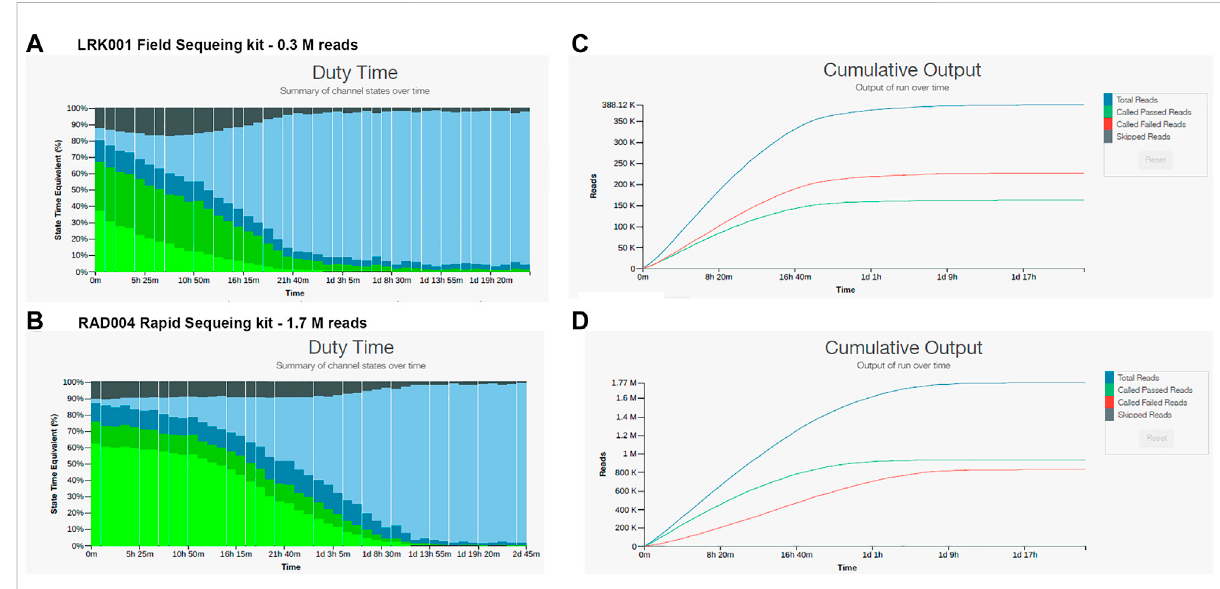
FIGURE 3 Nanopore sequencing outputs for sample 26 using the LKR001 fi eld sequencing kit and the RAD004 rapid sequencing kit. (A) Pore sequencing andavailabilityshowinglowporeavailabilityandporedeathafter16 h. (B) CumulativeoutputoftheLRK001kitshowingthatreadspassing fi lterwere equal to the reads not passing fi lter indicative of problems with the sequencing. (C) Pore availability for the RAD004 kit showing that the pores decayed by 20 h of sequencing. (D) Cumulative output for the RAD004 kit, with a similar problem with the read quality with 50% passing fi lter.